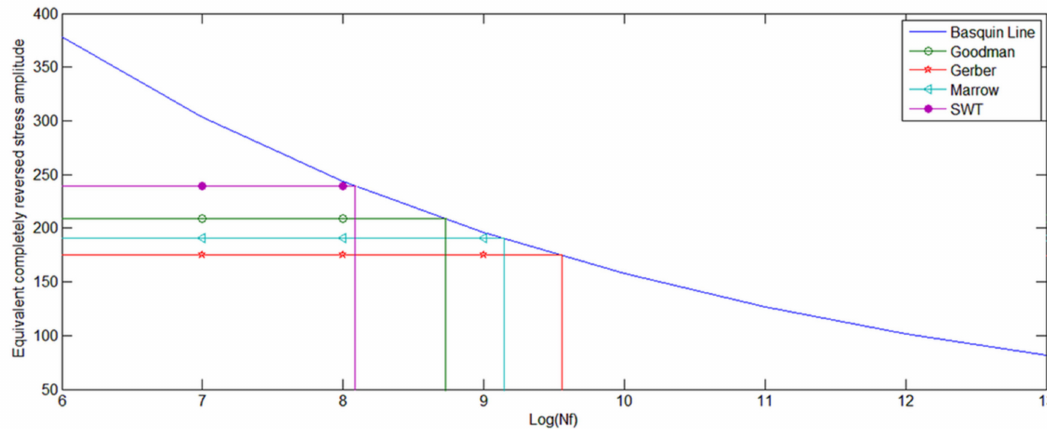
Figure 13. Plot of σ ar (Von Mises)-Log (N f ) for different models describing the implant.